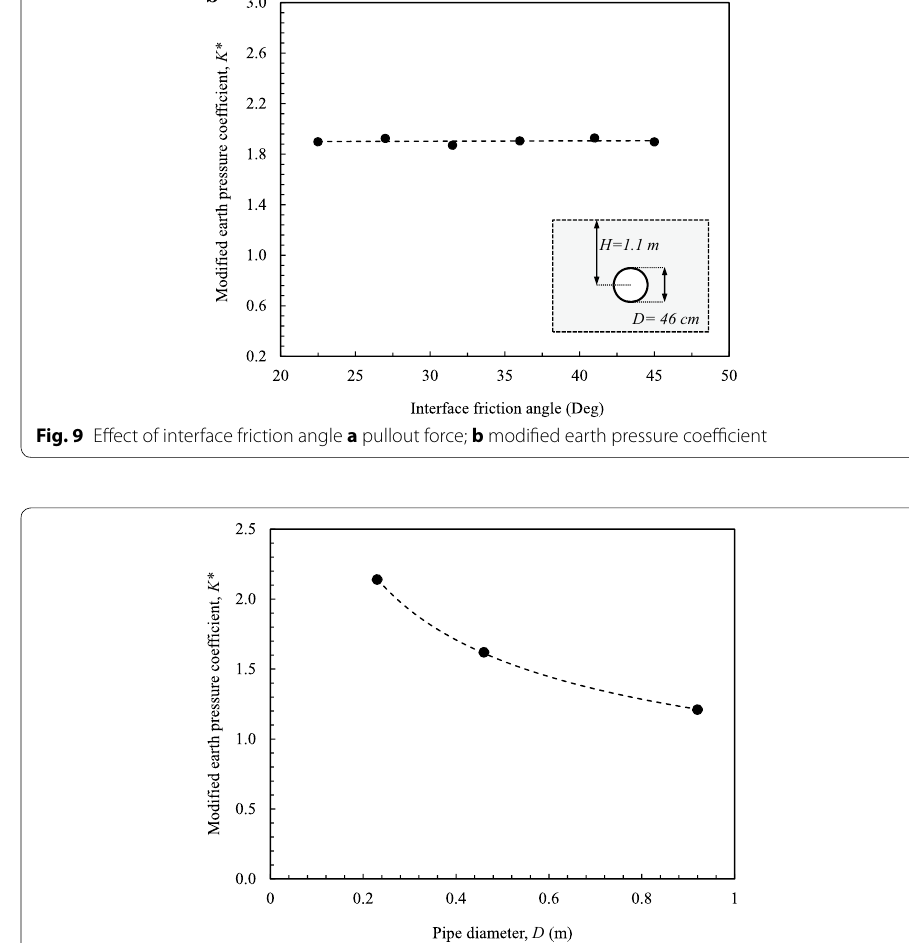
Fig. 10 Effect of pipe diameter on